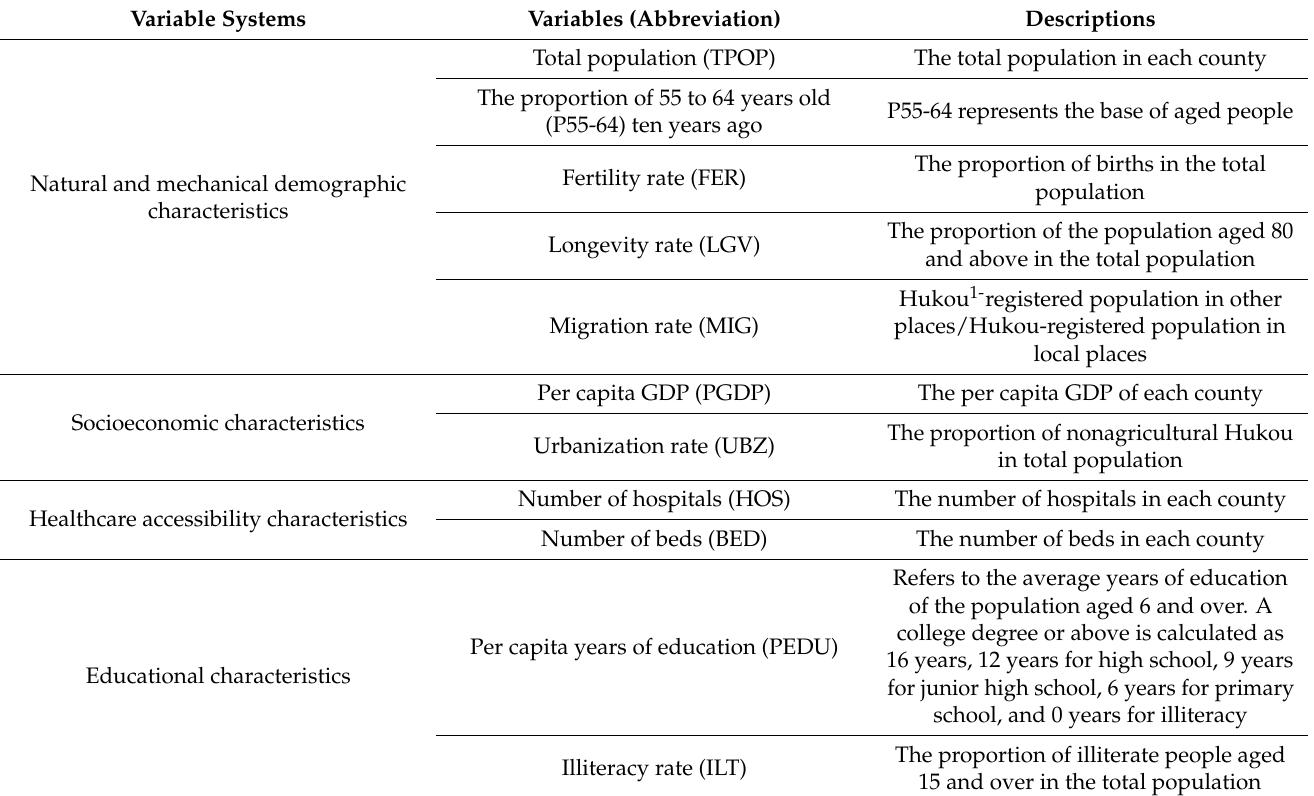
Table 1. Description of influencing variables on